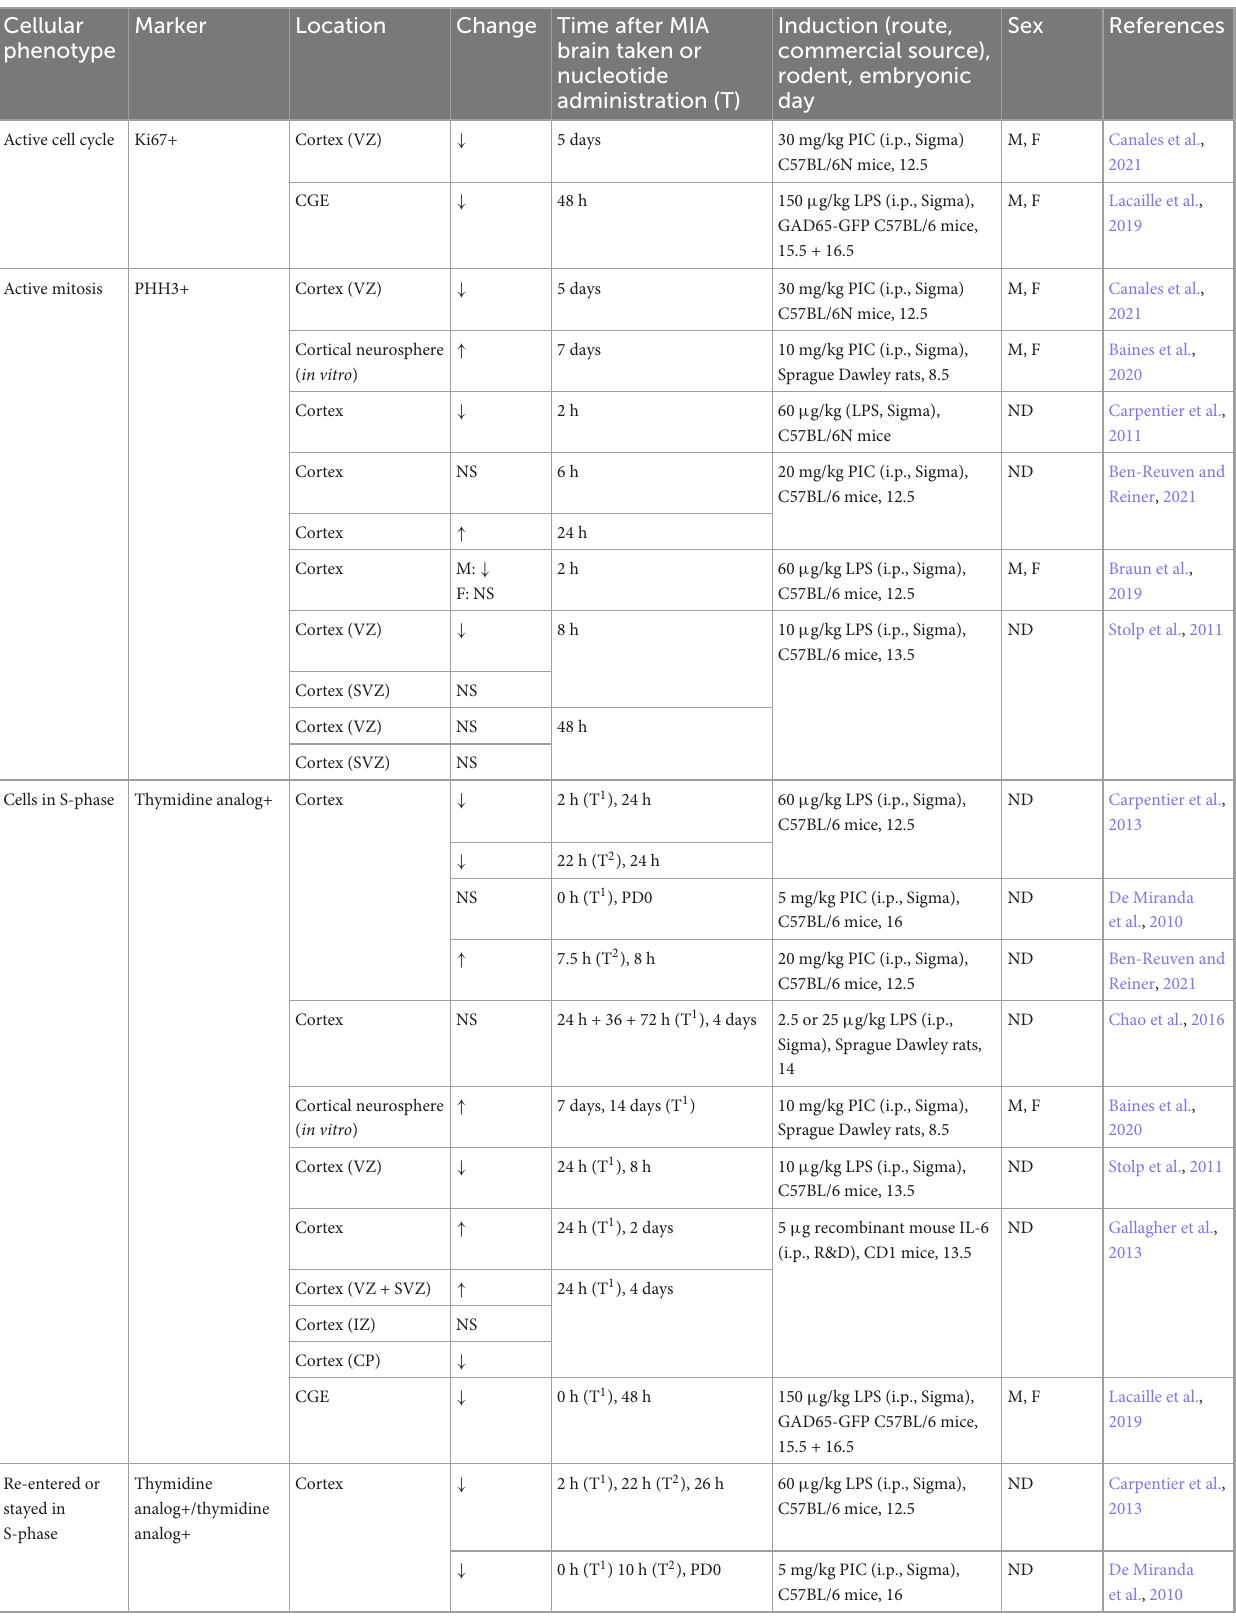
TABLE 1 Cell cycle phenotypes in fetal MIA offspring brains relative to vehicle controls. Cellular phenotype